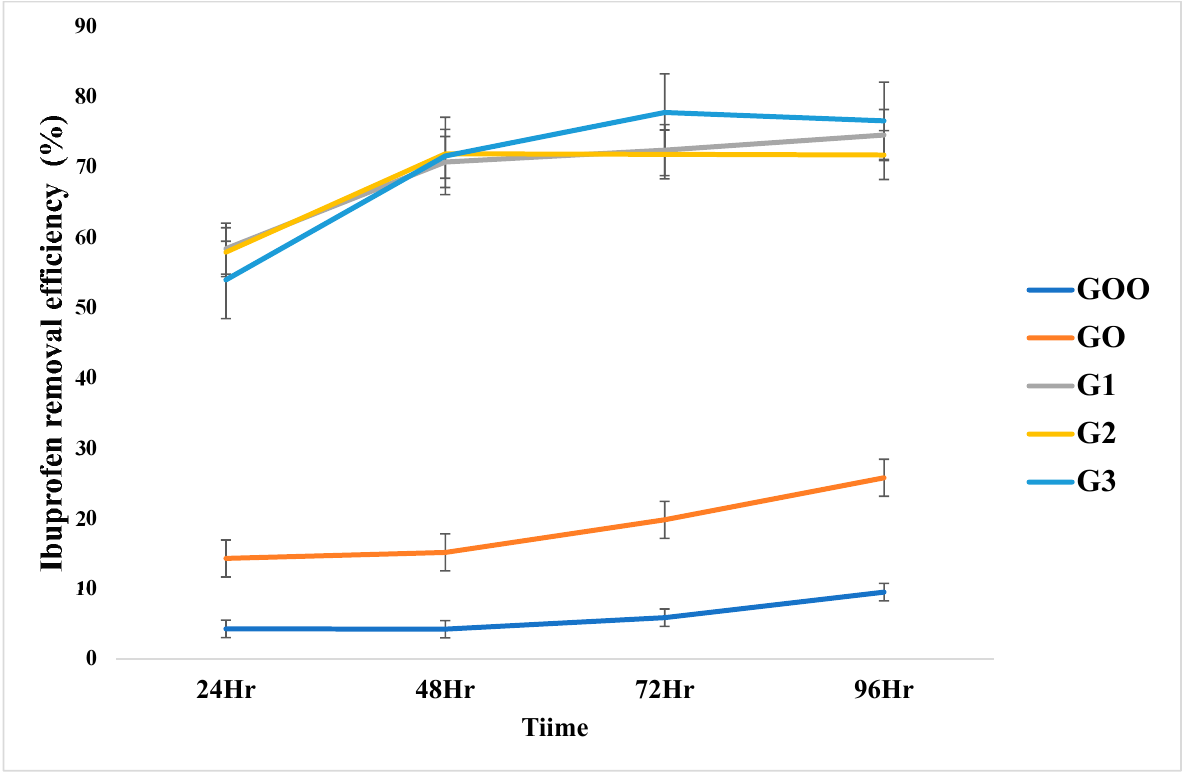
Figure 6. Effect of graphene concentration in the doped PIM on Ibuprofen extraction efficiency.